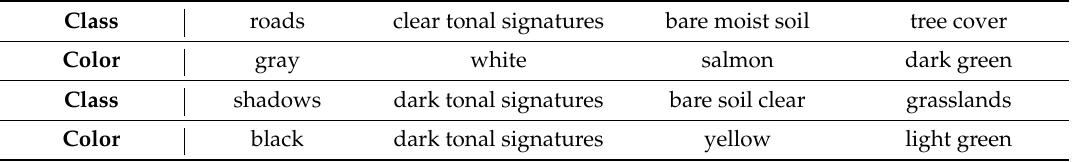
Table 2. Colors corresponding to the eight classes contained in the Ikonos-2 MS and Geoeye images. A ninth class that exists in Geoeye is the average tonal signatures with the red